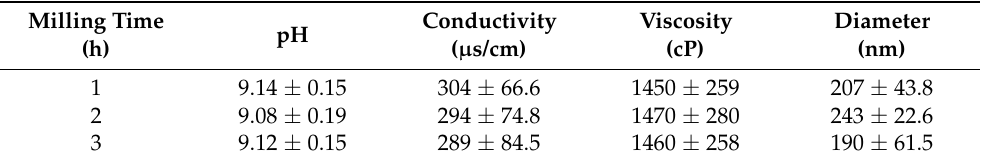
Table 3. pH, viscosity, conductivity, and diameter measured for CB dispersions prepared with SMA-3000 after storing 11